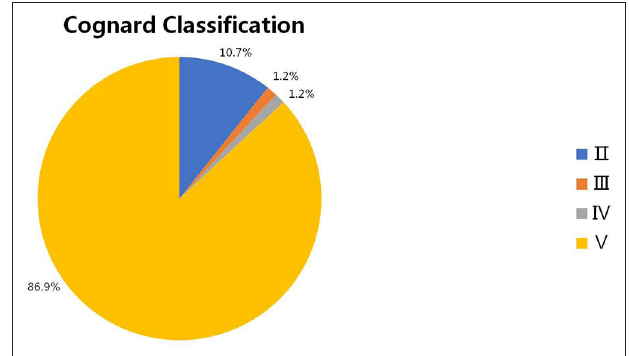
FIGURE 4 | The Cognard classification of intracranial DAVFs complicated with brainstem engorgement. DAVF, dural arteriovenous fistula.